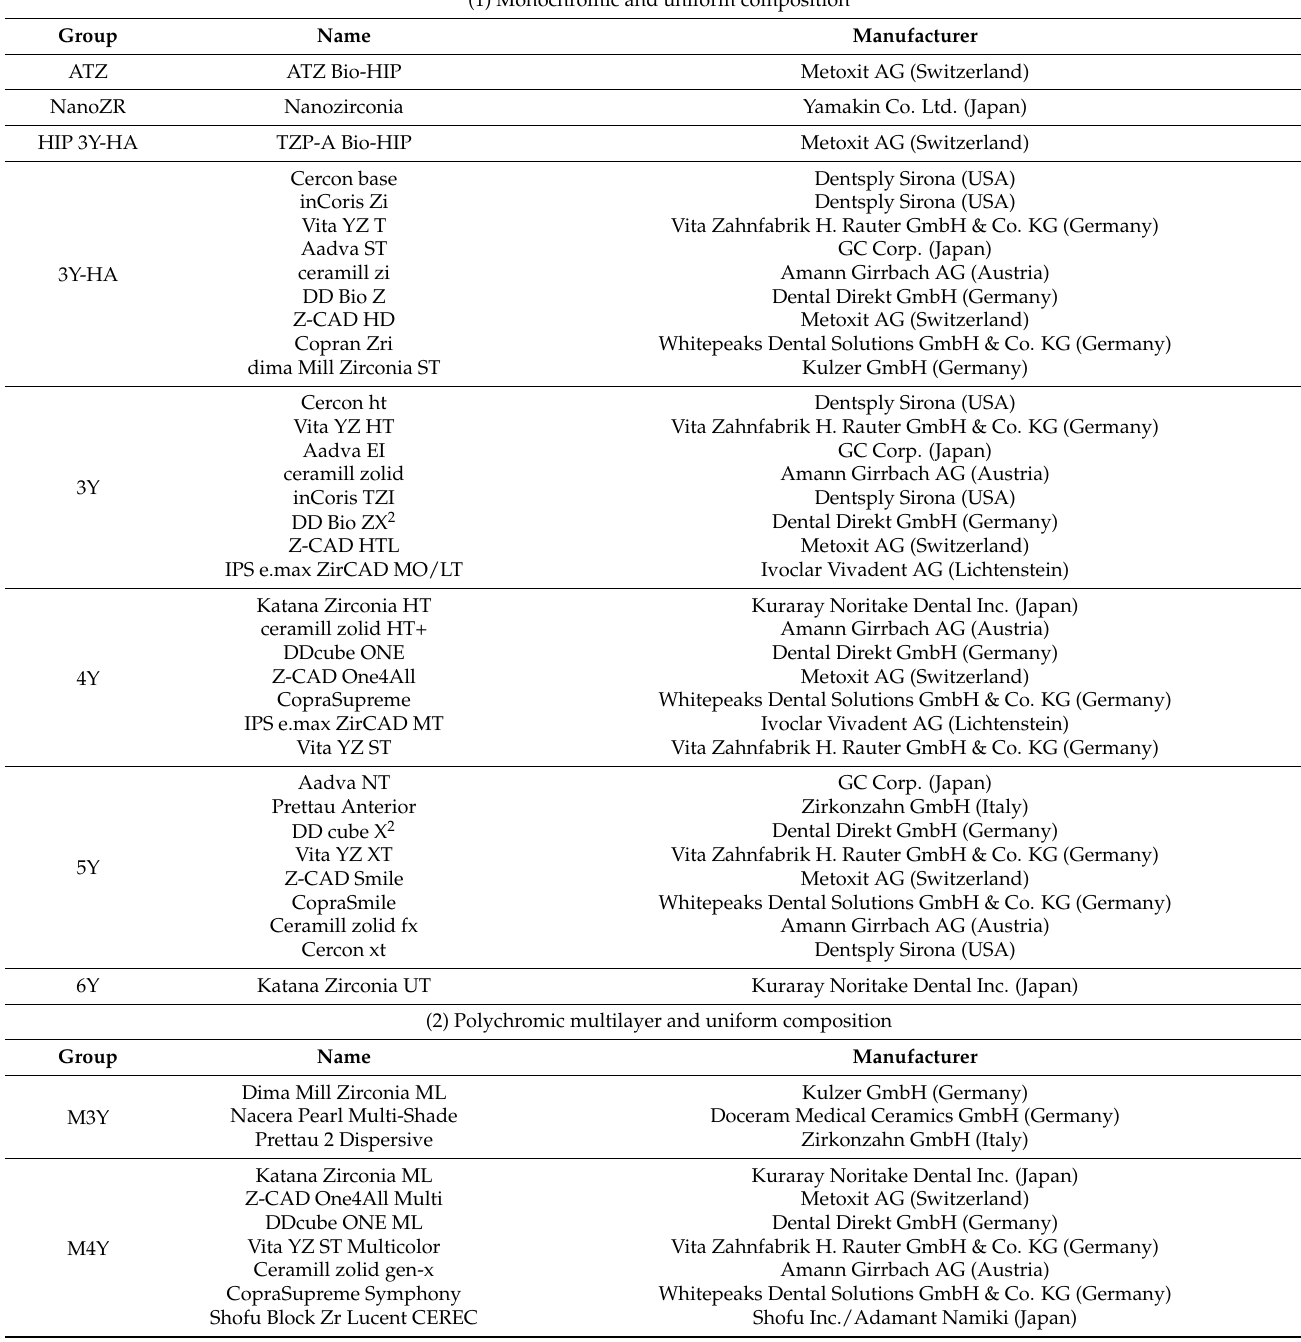
Table 2. Classification of dental